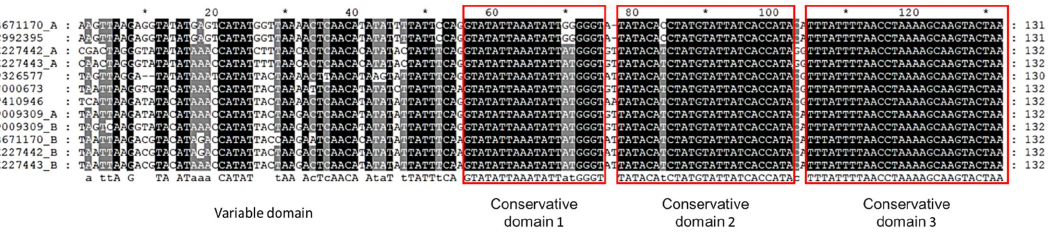
Figure 2. Aligned~130bp repetitive motif to show the conservative domain (in red box) and variable domain. The number on the right indicates the length of each repetitive motif. The number above indicates the position of the corresponding nucleotides. The sign “*” between the two numbers indicates the midpoint between them.